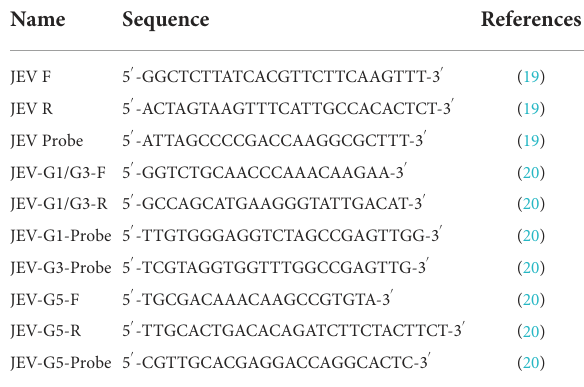
TABLE 1 Primers and probes used to detect and genotype JEV in this